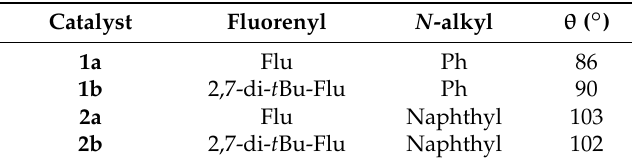
Table 4. Tolman’s cone angle of amido groups of complexes 1a , 1b , 2a , and 2b